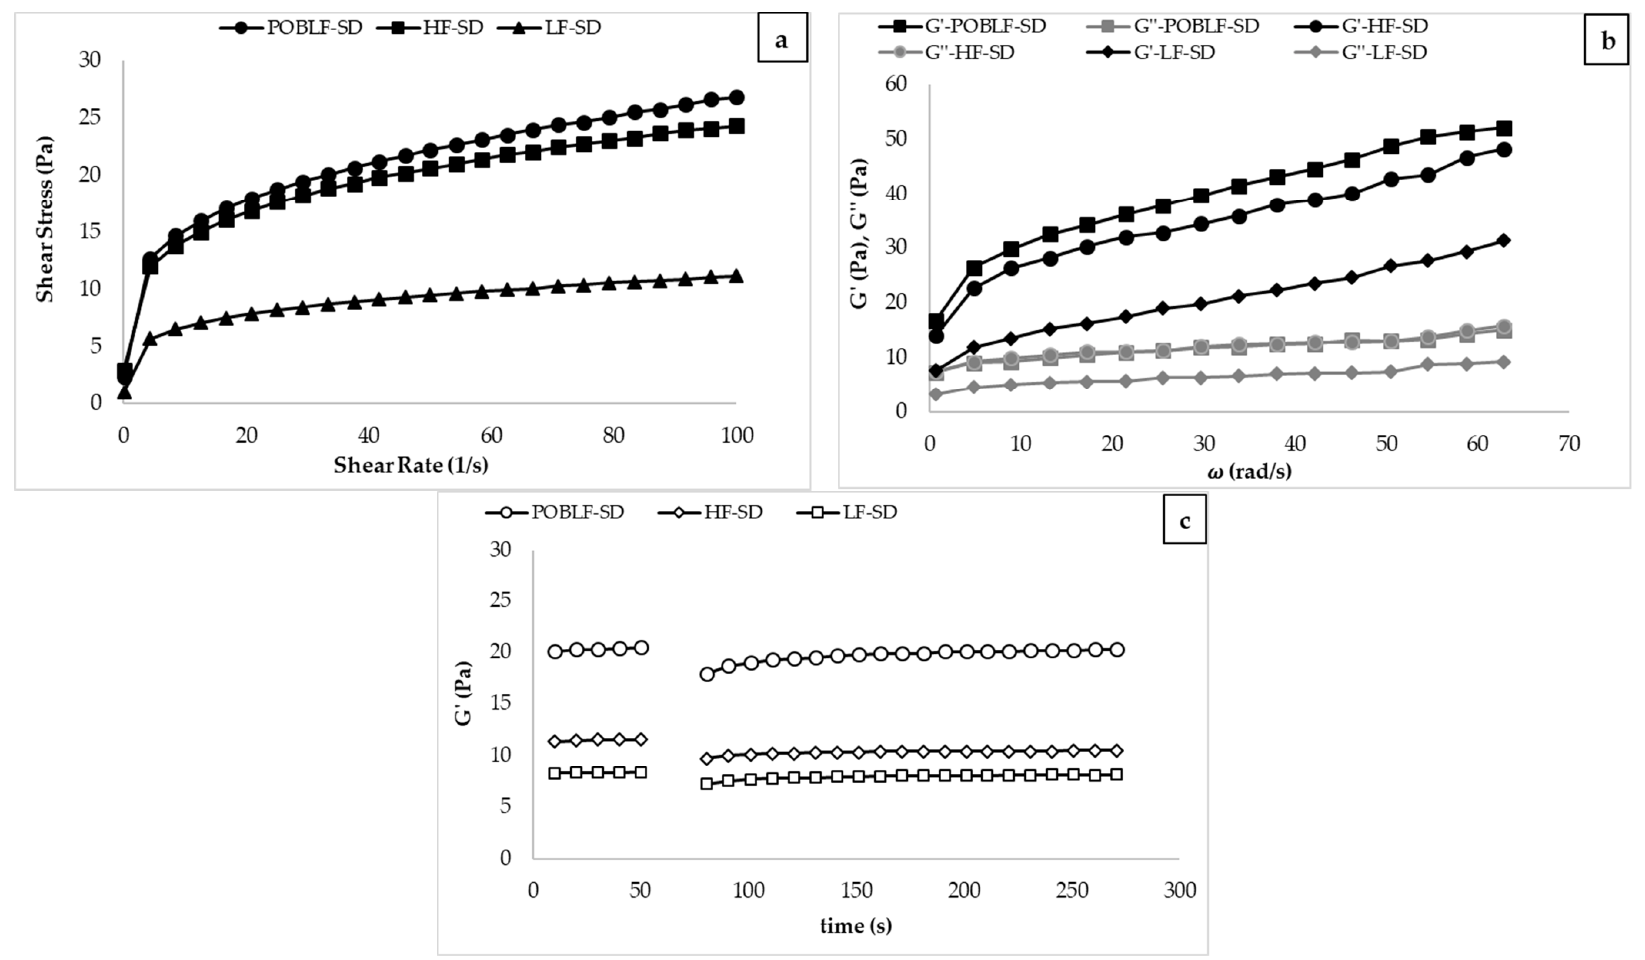
Figure 5. Rheological properties of POBLF-SD, HF-SD, LF-SD (HF-SD: high-fat salad dressing sample; LF-SD: low-fat salad dressing sample; POBLF-SD: low-fat salad dressing sample with cold-pressed pumpkin seed oil by-product; G ′ (Pa): storage modulus, G ″ (Pa): loss modulus). ( a ): The flow behavior of POBLF-SD, HF-SD, LF-SD; ( b ): The dynamic rheological behavior of POBLF-SD, HF-SD, LF-SD; ( c ): The 3-ITT rheological behavior of POBLF-SD, HF-SD, LF-SD.